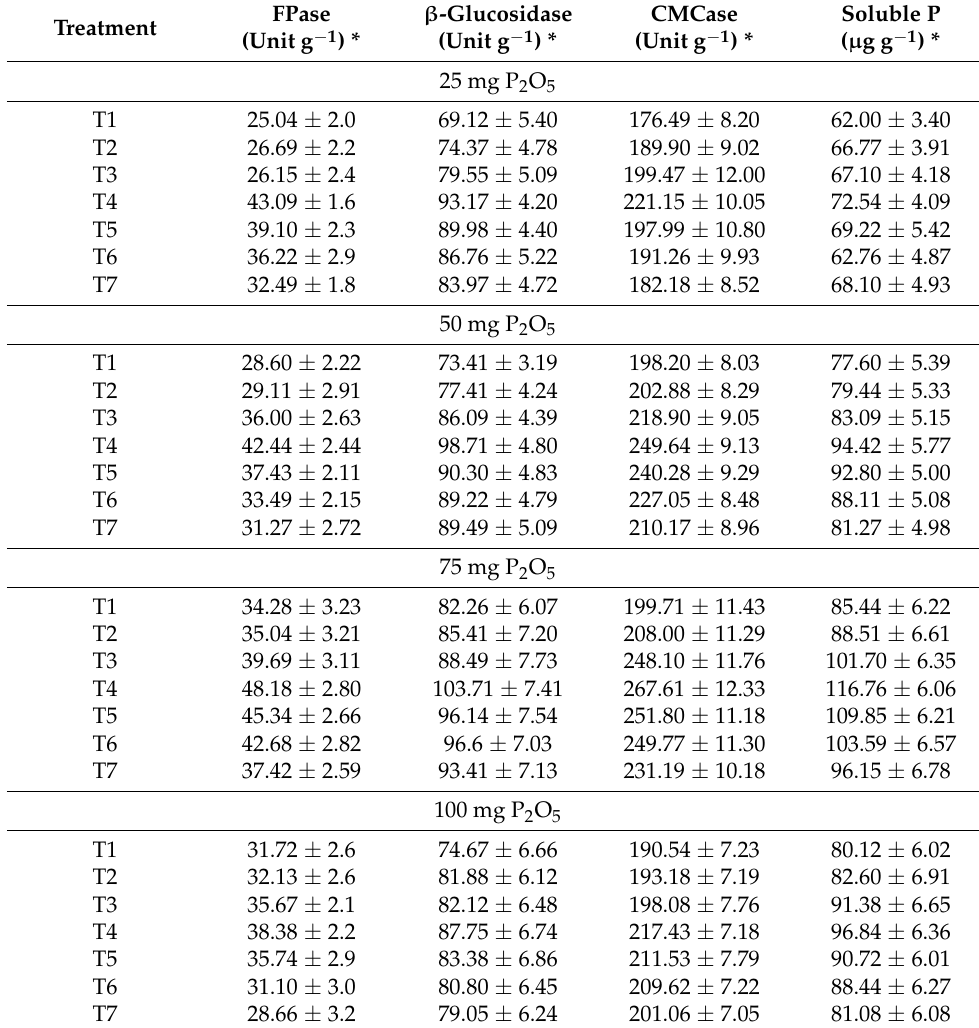
Table 4. Concentrations of RP cellulase production and P solubilization by A. japonicus under different ratios of sugarcane bagasse and faba bean straw residues after 4-week incubation. FPase Treatment (Unit g − 1 )